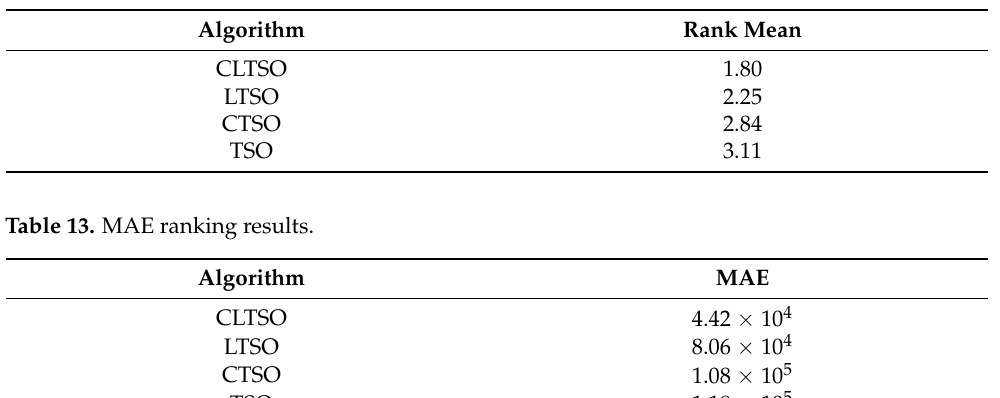
Table 12. Results of Friedman statistical analysis.